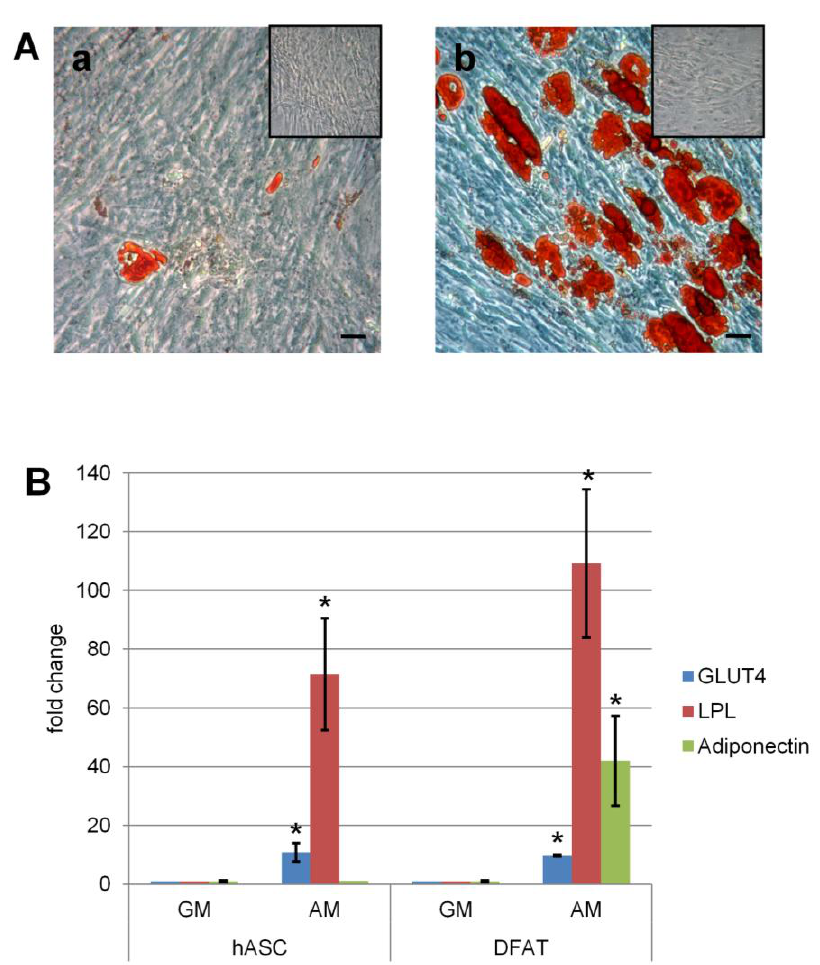
Figure 2. Adipogenic differentiation in hASC and DFAT in the presence (AM: adipogenic medium) or absence (GM: growth medium) of adipogenic factors. ( A ) Microscopic evaluation in hASC ( a ) and DFAT ( b ) cells of the presence of intracellular lipid droplets by Oil Red O stain at 15 days and their respective control (inset). Bars, 100 µm; ( B ) expression of LPL , GLUT4 and adiponectin of DFAT and hASC cells after 15 days in culture. Data expressed as fold change in cell in adipogenic medium (AM) versus cell in growth medium (GM). * p ≤ 0.05. Table 2. Quantification of lipid droplets in hASC and DFAT on digitized images of Oil Red O staining at 15 days. *, p ≤ 0.05.